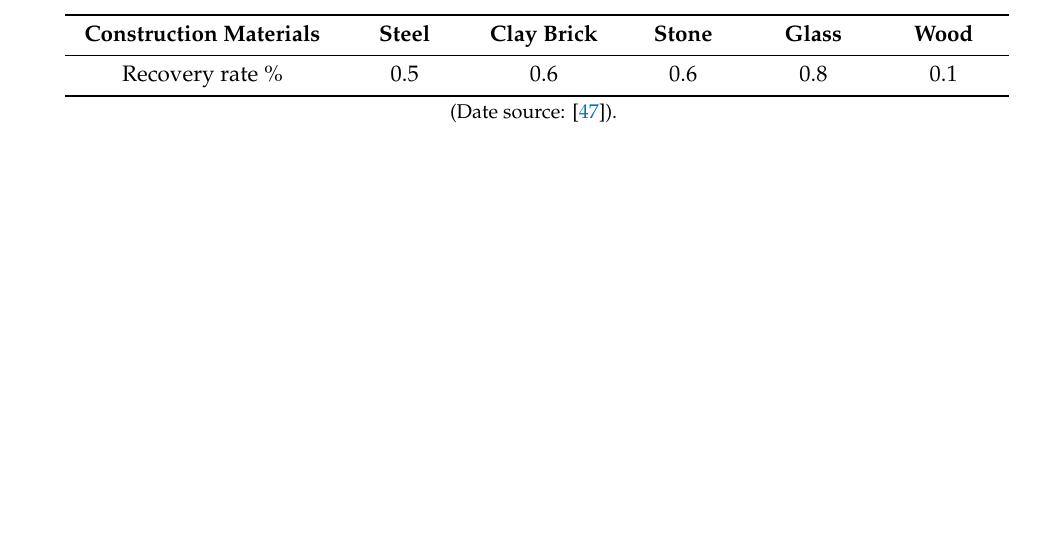
Table A6. Recovery rates for di ff erent construction